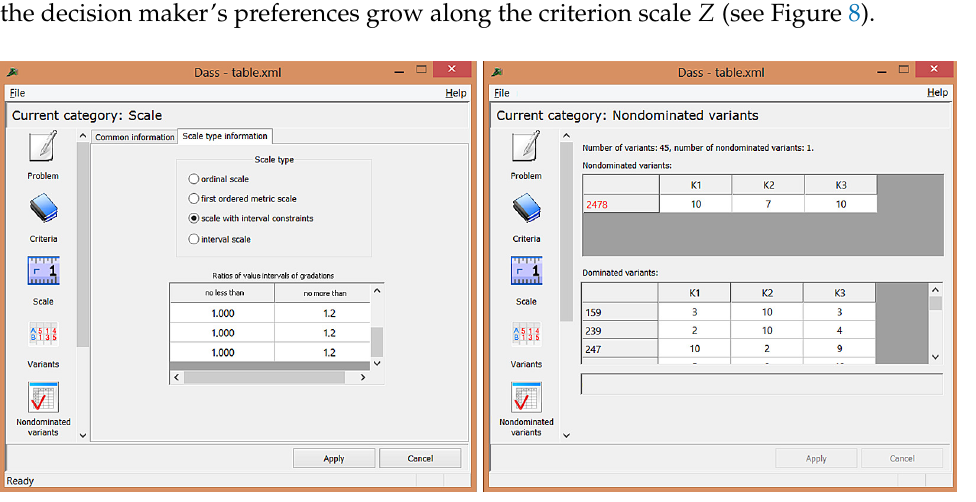
Figure 8. Non-dominated vector scores based on information on the scale of